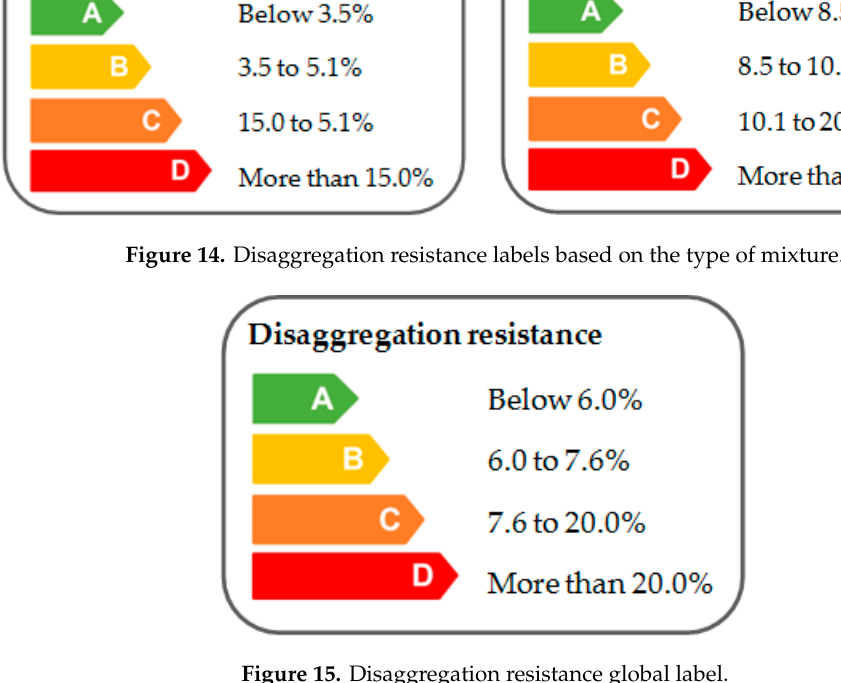
Figure 16. ITSR labels based on the type of mixture. Figure 17. ITSR global label. Finally, all results related to the cracking resistance of the mixture were obtained during the laboratory stage. In this case, two opposite indicators are used to explain this property. On one hand, the tensile strength (TS) represents the cohesion provided by the asphalt mastic and, on the other hand, the displacement at 50% post ‐ peak load (d 0.5PostFmax ) is directly related to the ductility of the